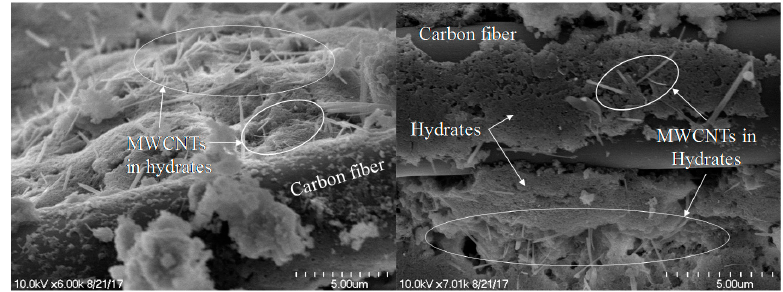
Figure 14. SEM images of cement-based composites with hybrid fillers as both CFs and MWCNTs. The FCR vs. compressive strain of cement-based composites with both CFs and MWCNTs is shown in Figure 15. As expected, when 0.1 vol.% CFs and 0.5 vol.% MWCNTs were incorporated in